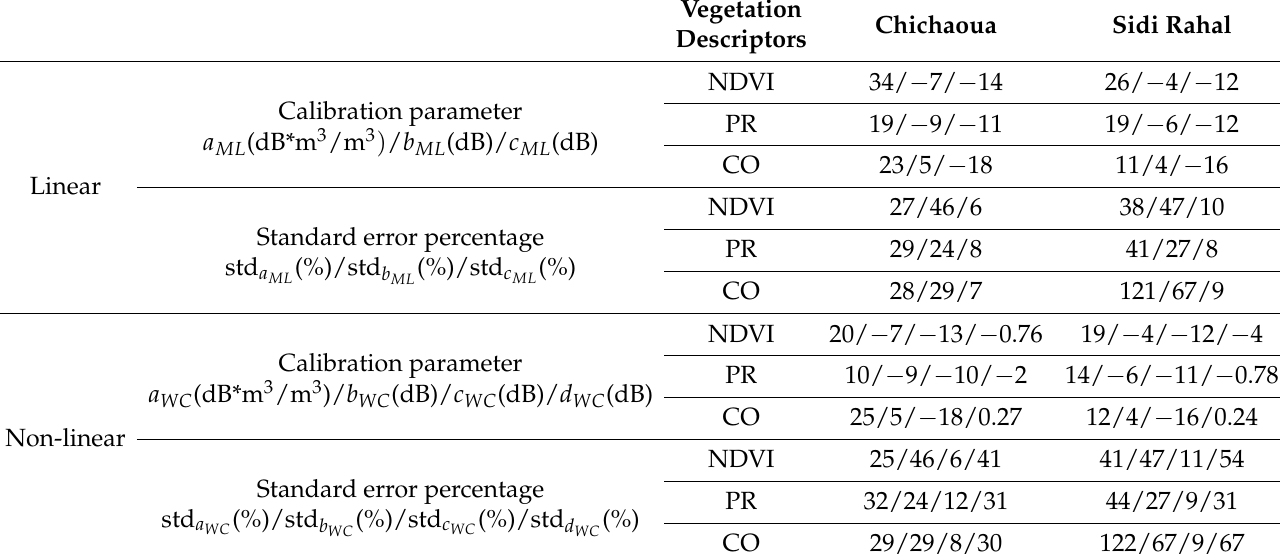
Table 2. Same as Table 1 where DISPATCH SM data are used for the